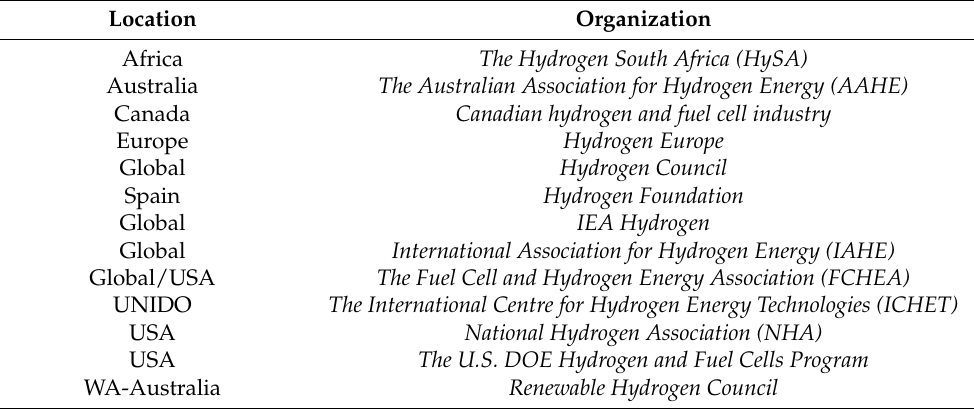
Table 1. National and international hydrogen